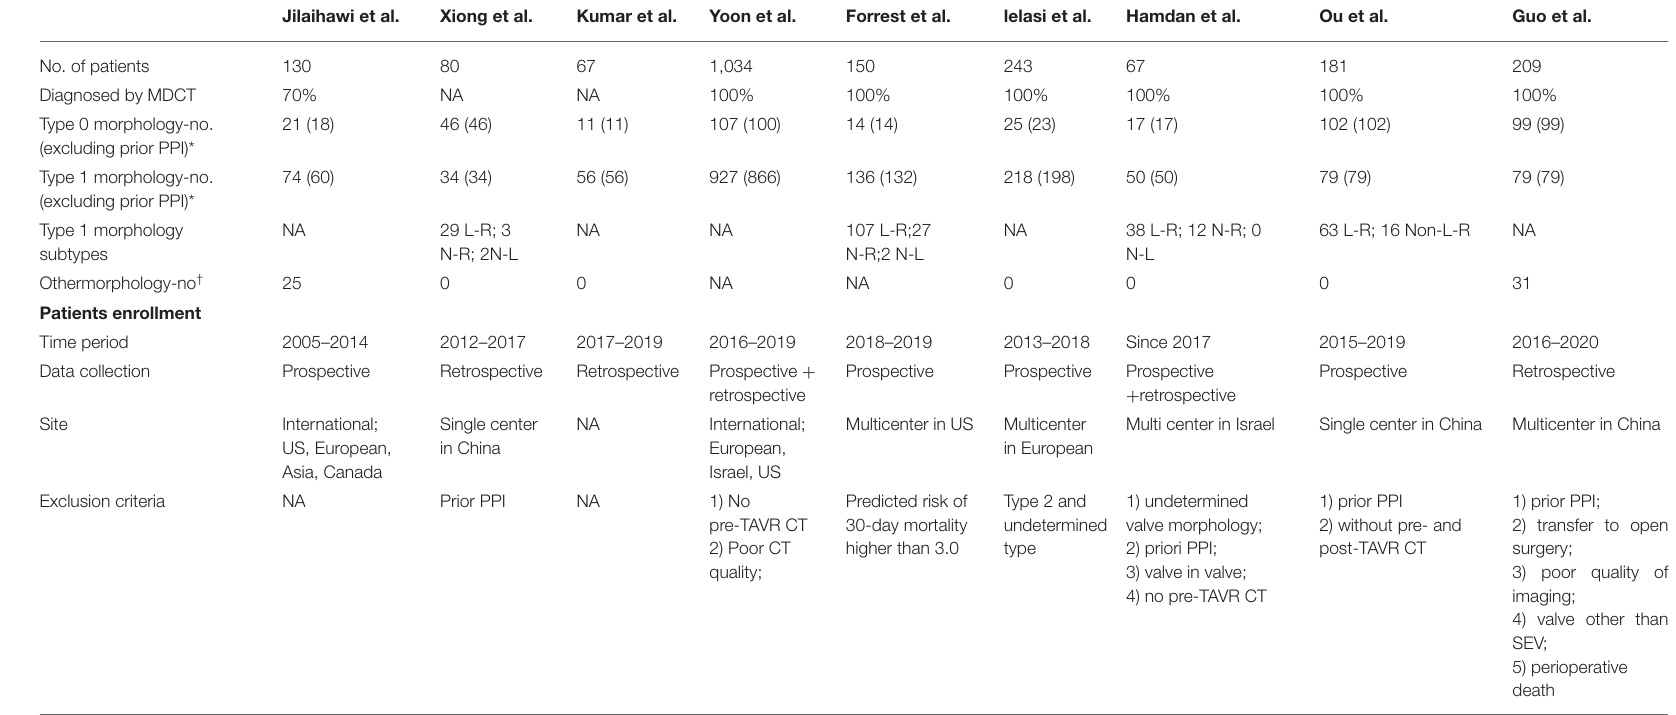
TABLE 2 | Overview of the included